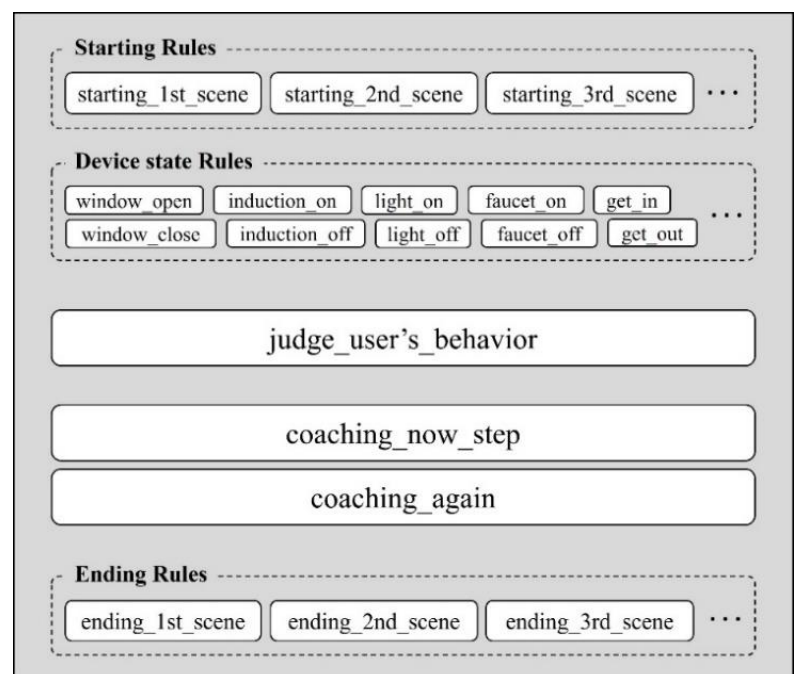
Figure 8. The main components of the knowledge base required for ADL evaluation and the modular rules that are included with them.